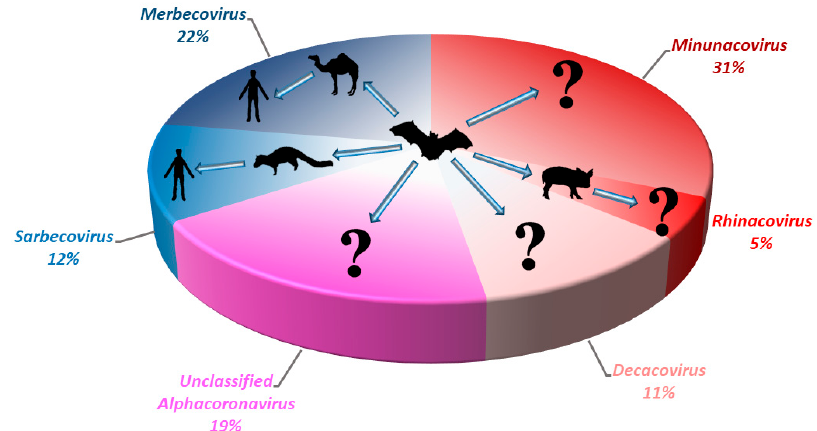
Figure 3. Pie chart showing the relative detection rate of different bat CoVs from different subgenera of Alphacoronavirus and Betacoronavirus in Hong Kong from 2008 to 2017. The potential zoonotic transmission routes of each sub-genus of bat CoV detected are shown. Unclassified Alphacoronavirus represents those without complete genome sequences or genome characterization. Red color represents the sub-genera from Alphacoronavirus ; Blue color represents the sub-genera from Betacoronavirus .